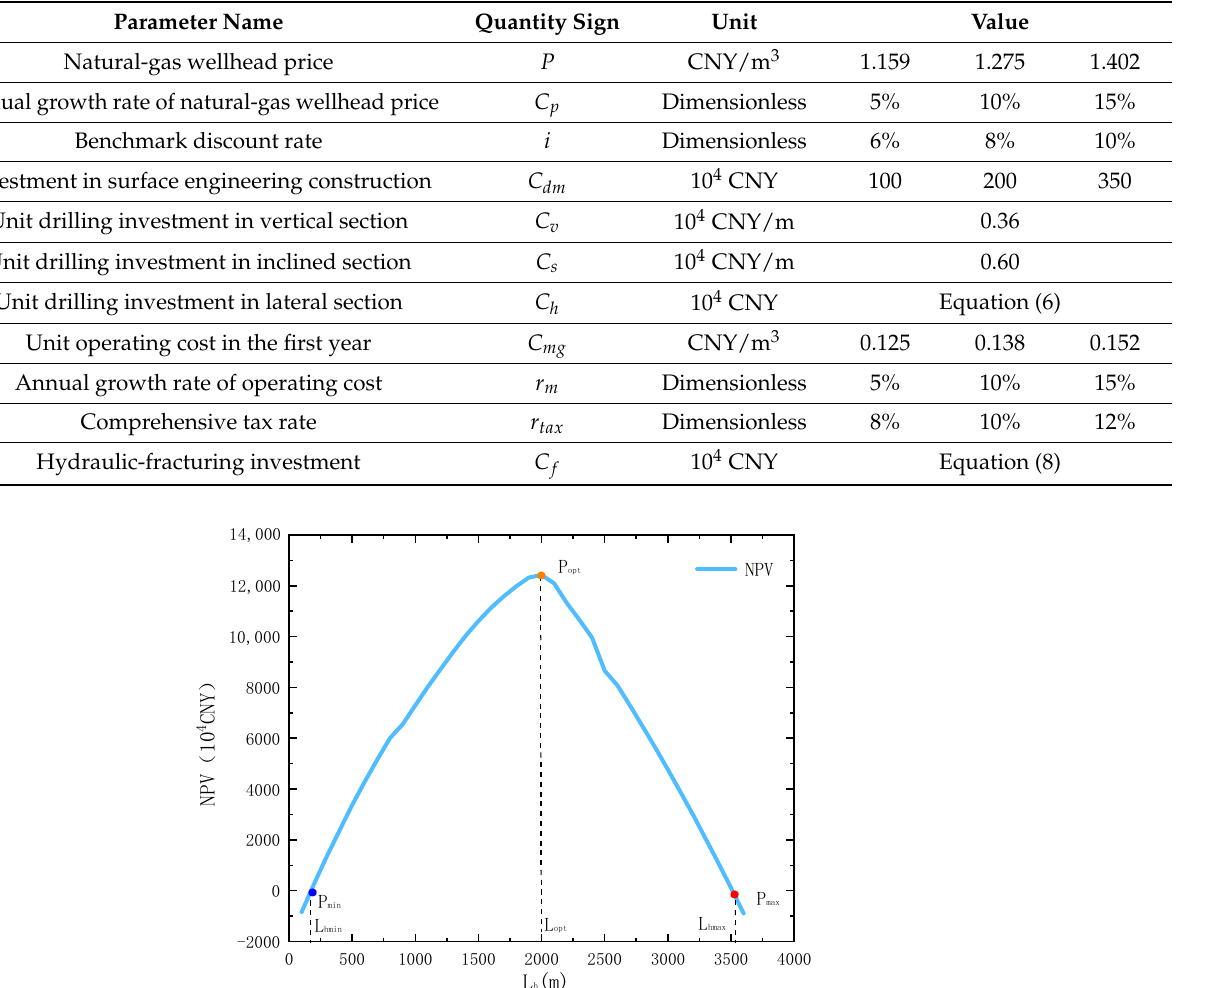
Table 4. The economic parameters of the shale-gas horizontal well.